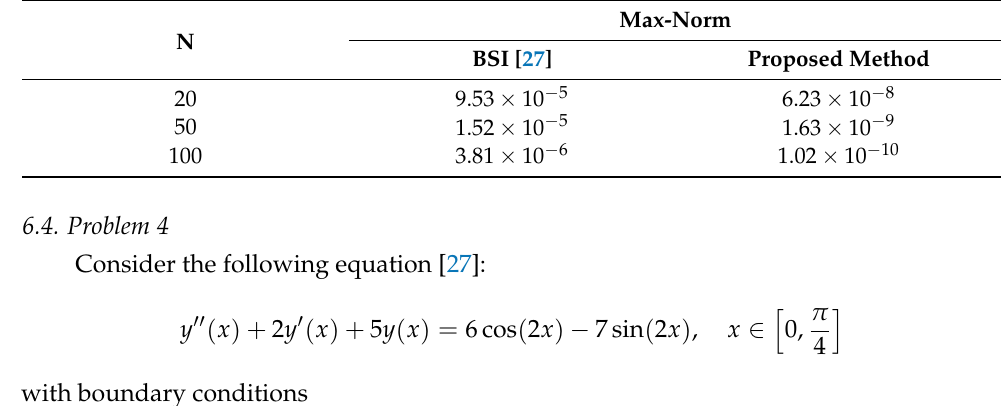
Table 7. Comparison of maximum errors for Problem 3.